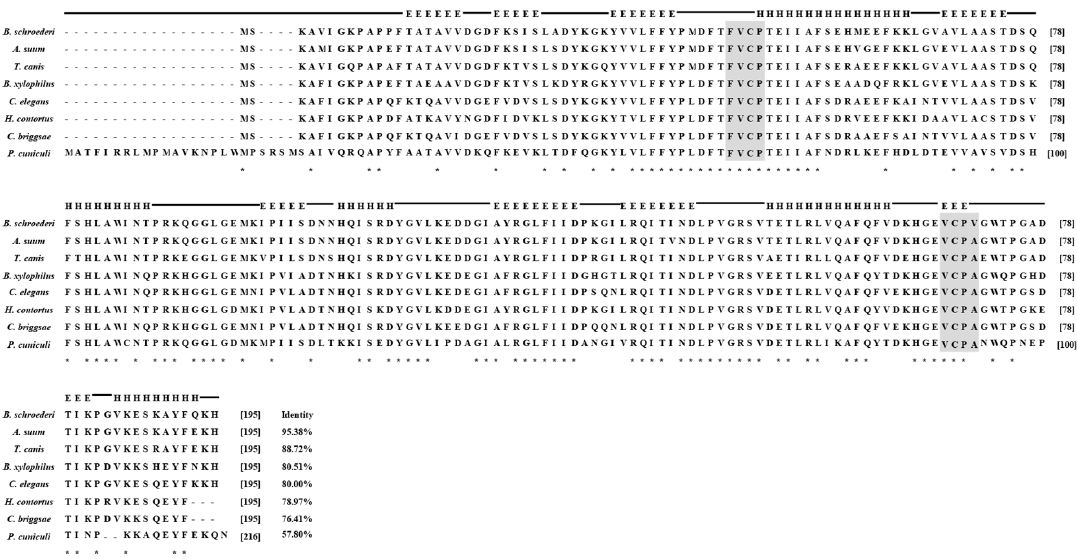
Figure 2. Multiple sequence alignment of B. schroederi thioredoxin peroxidase (BsTpx). A. suum (Q9NL98.1), T. canis (KHN73050.1), Bursaphelenchus xylophilus (ABW81468.1), C. elegans Caenorhabditis elegans (NP_872052.1), H. contortus (AAT28331.1), Caenorhabditis briggsae (XP_002630699.1), Psoroptes